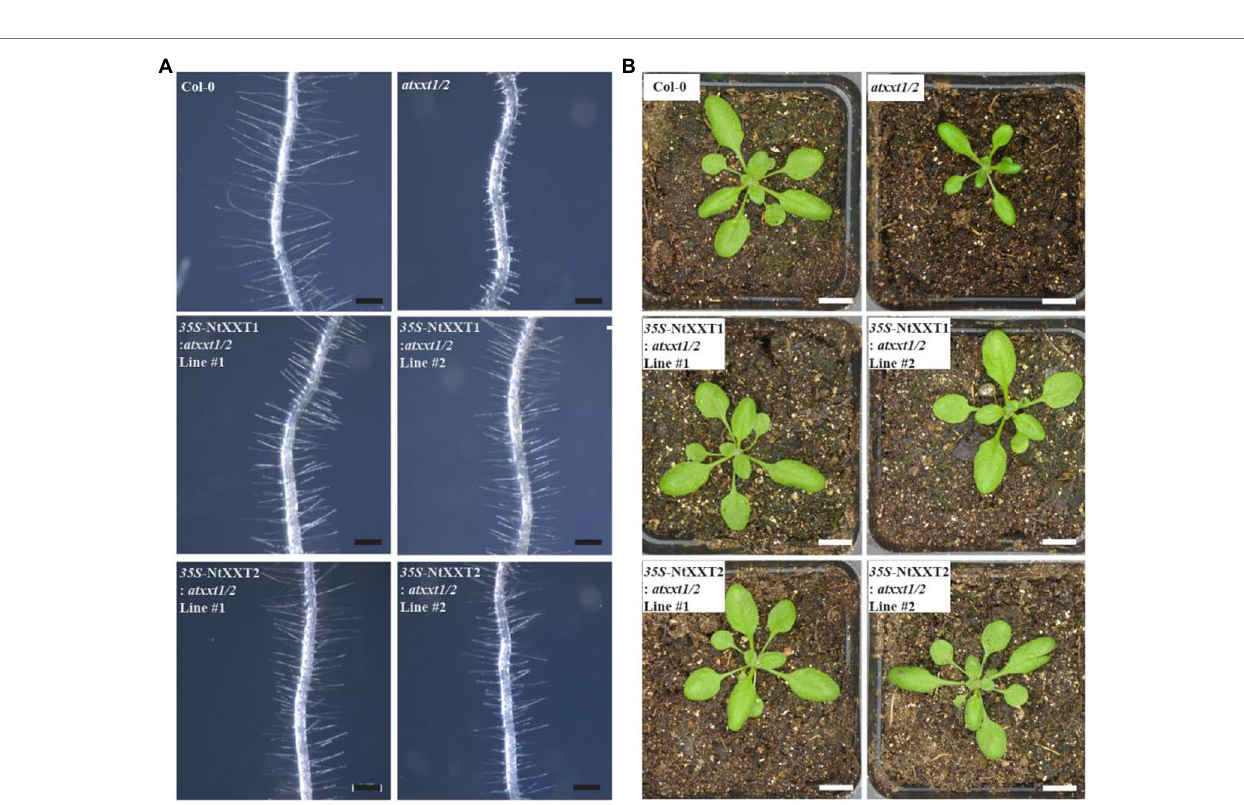
FIGURE 6 | The root hair and plants phenotypes of complemented atxxt1/2 lines. (A) The root hair phenotypes of 7 day-old Arabidopsis seedlings were observed. The root hairs of the atxxt1/2 double mutant are far shorter than Col-0. Overexpressing 35S -NtXXT1 or 35S -NtXXT2 in atxxt1/2 plants rescues the root hair defect of the atxxt1/2 double mutant. Bar = 100 μ m. (B) The 3-week-old plants phenotype was observed. The atxxt1/2 double mutant plants were smaller than Col-0, and overexpressing 35S -NtXXT1 or 35S -NtXXT2 in atxxt1/2 plants were recovered. Bar = 10